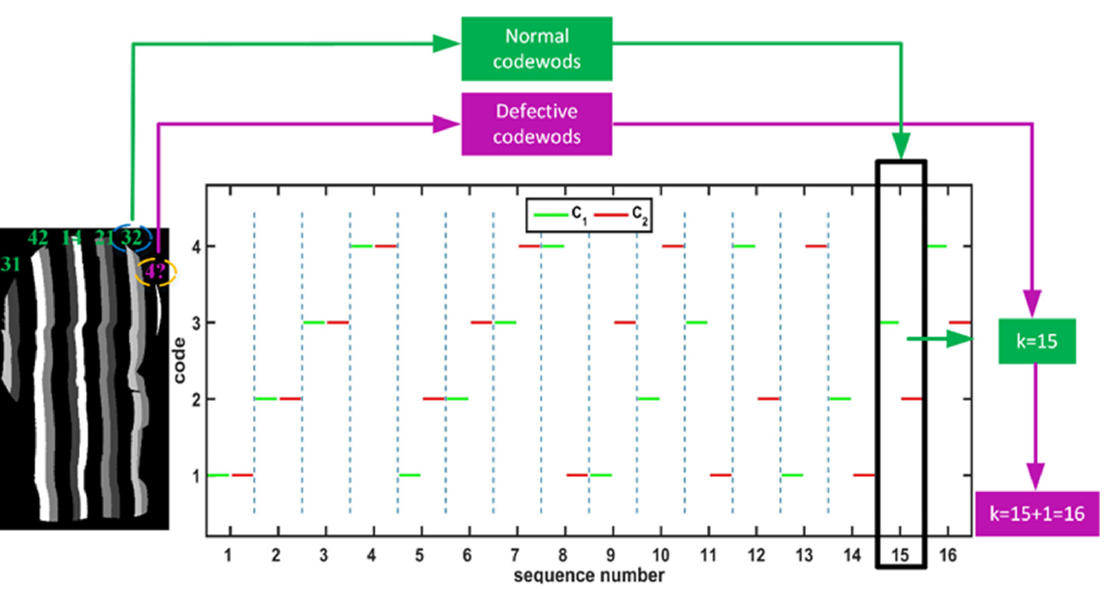
Figure 3. The procedure of the unwrapping strategy.